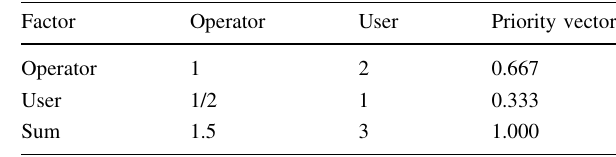
Table 3 Pairwise comparison matrix of the